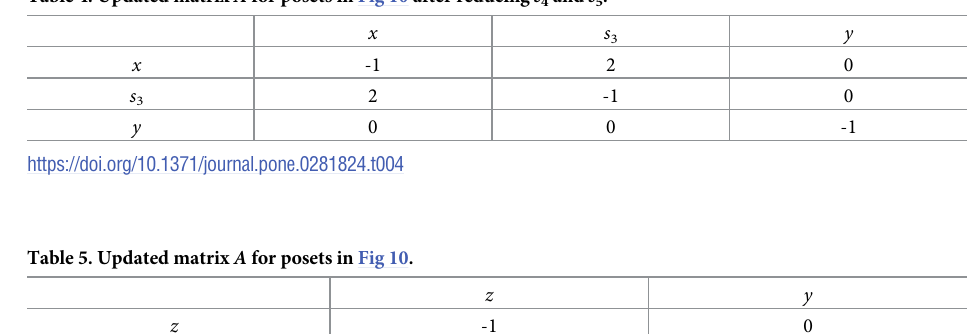
Table 4. Updated matrix A for posets in Fig 10 after reducing s 4 and s 5 .